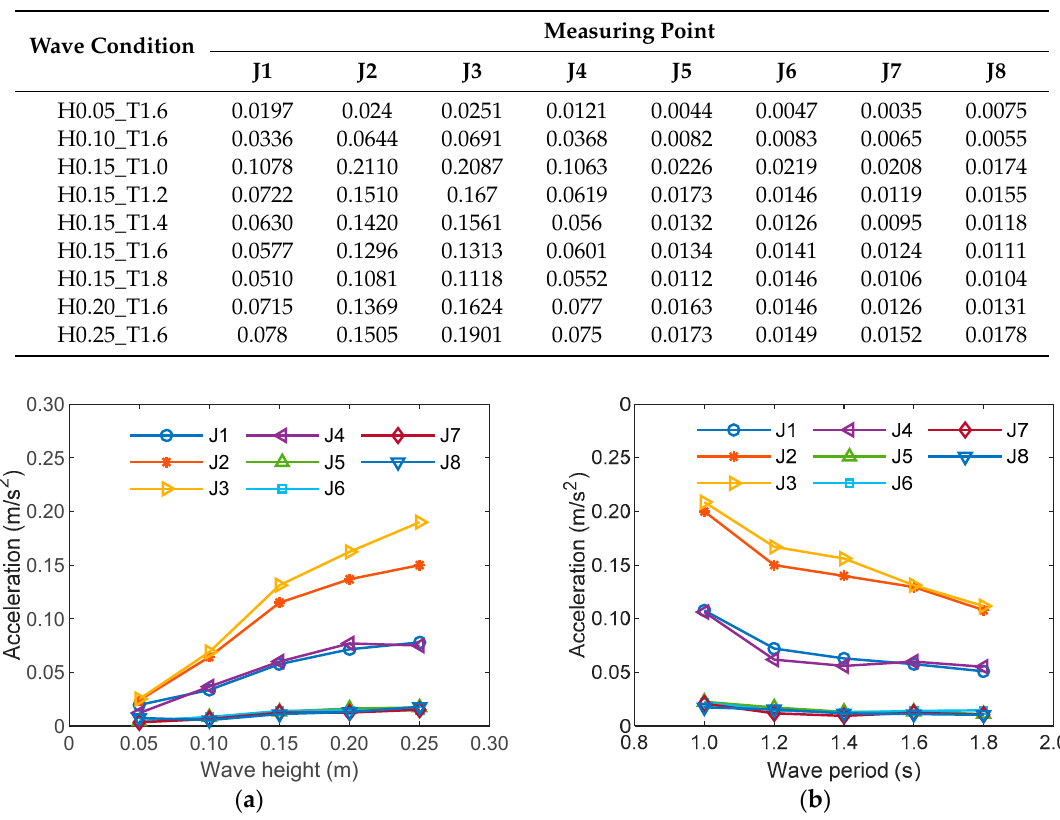
Table 8. Peak values of acceleration response at various measurement positions in waves (unit: m / s 2 ).